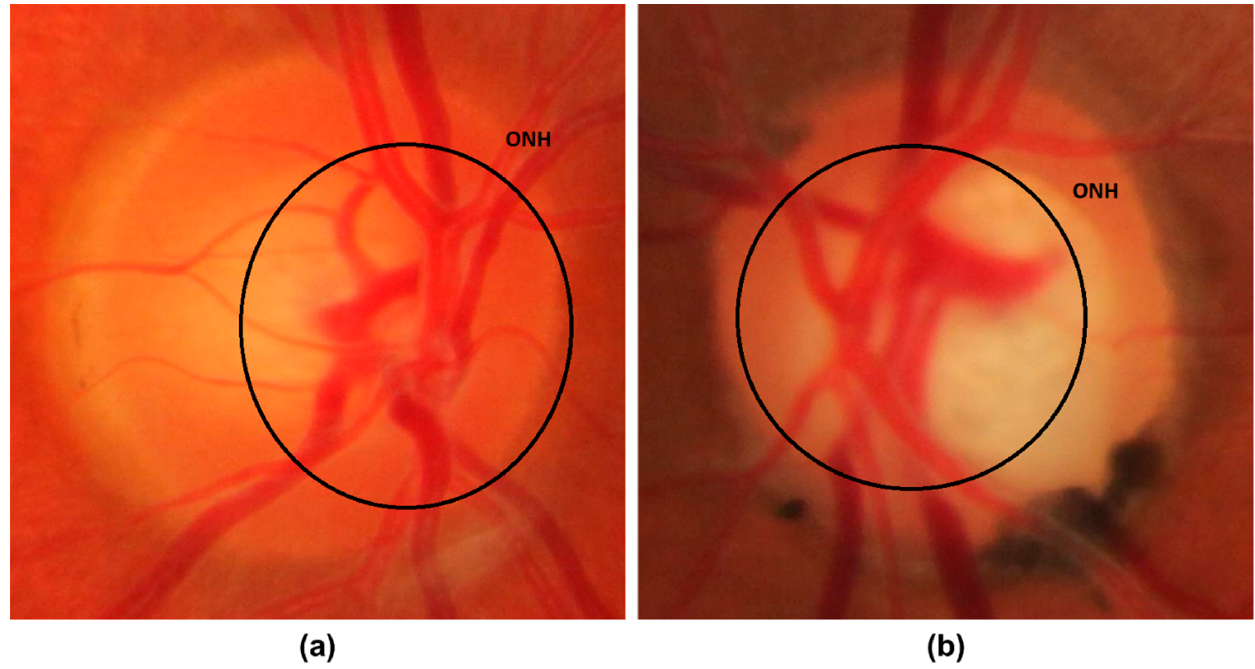
Figure 1. Optic Nerve Head images ( a ) Normal eye ( b ) Glaucomatous eye image.